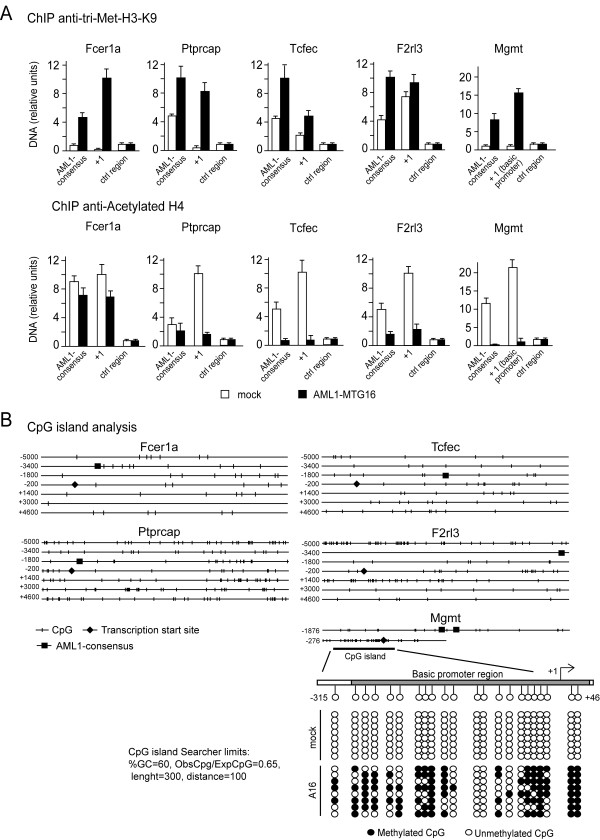
Repressive epigenetic changes at the AML1-targets. A. ChIP with antibodies against either acetylated histone H4 or tri-methylated histone H3 Lysine 9 (tri-Met-H3-K9) followed by quantitative PCR with primers amplifying a region encompassing either the transcription start site (+1) or the AML1-consensus detected a different level of repressive histone changes in all five genes in A16 cells. B. In silico analysis identified a CpG island only in the Mgmt promoter. This CpG island is hypermethylated in A16 cells (bottom, right).